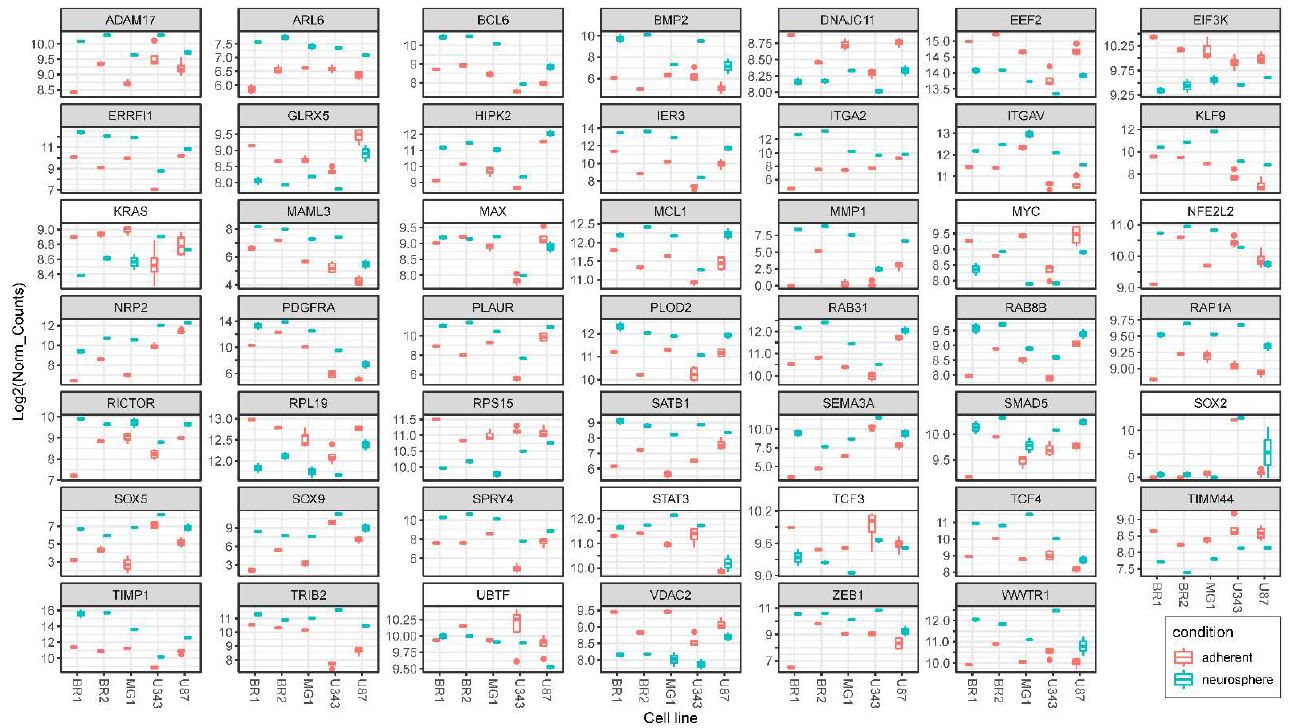
Figure 4. Differences in relative mRNA levels in adherent glioma cultures and neurospheres. Box plots of DESeq2 normalized expression values of mRNAs grouped by glioma cell lines and colored red for monolayer (adherent) cultures and cyan for corresponding NS. Plots with gray shaded headers represent data for differentially expressed genes that meet the criteria DESeq2 padj < 0.05, Log2FoldChange > 0 for upregulated or log2FoldChange < 0 for downregulated transcripts (for all MN/NS pairs in one direction—synchronously “up” or “down”). Plots with white shaded headers represent mRNA levels of TFs and KRAS that do not meet the criteria for differentially expressed genes (discussed in text).